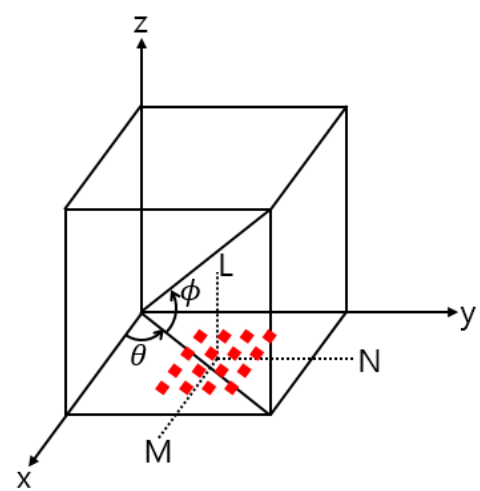
Figure 1. Geometry of a uniform rectangular array, where each element is a red diamond.